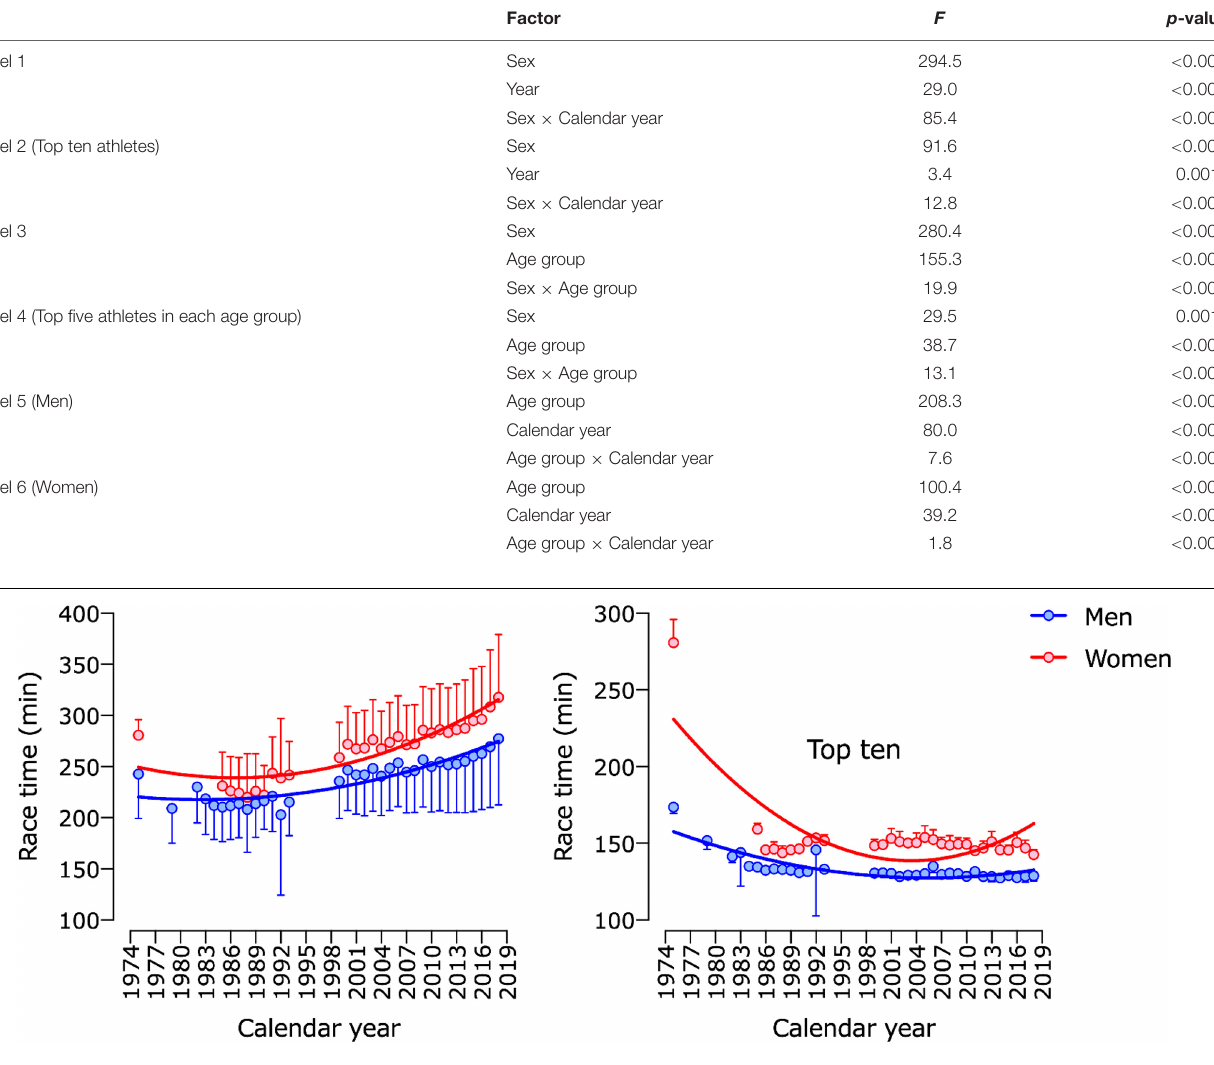
FIGURE 2 | Race time of men and women in “Berlin Marathon” across calendar